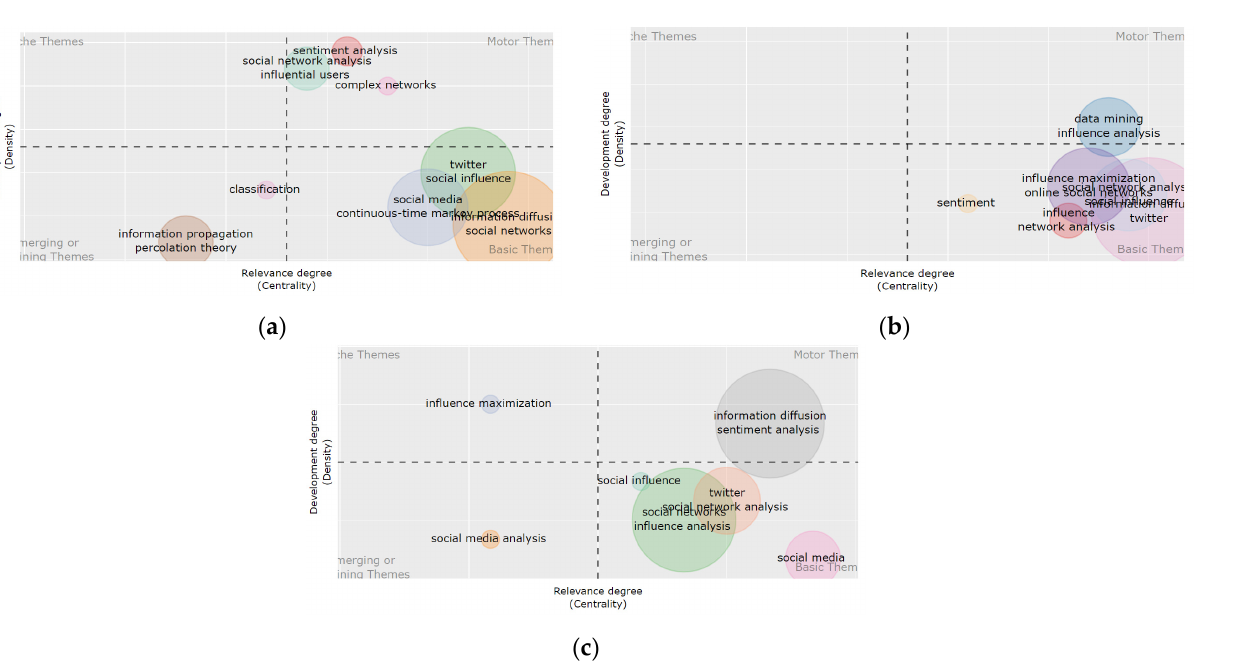
Figure 7. ( a ) Thematic map Dataset 1 for time slice 1 (2011–2016), ( b ) thematic map Dataset 1 for time slice 2 (2017–2019), and ( c ) thematic map Dataset 1 for time slice 3 (2020–2021).